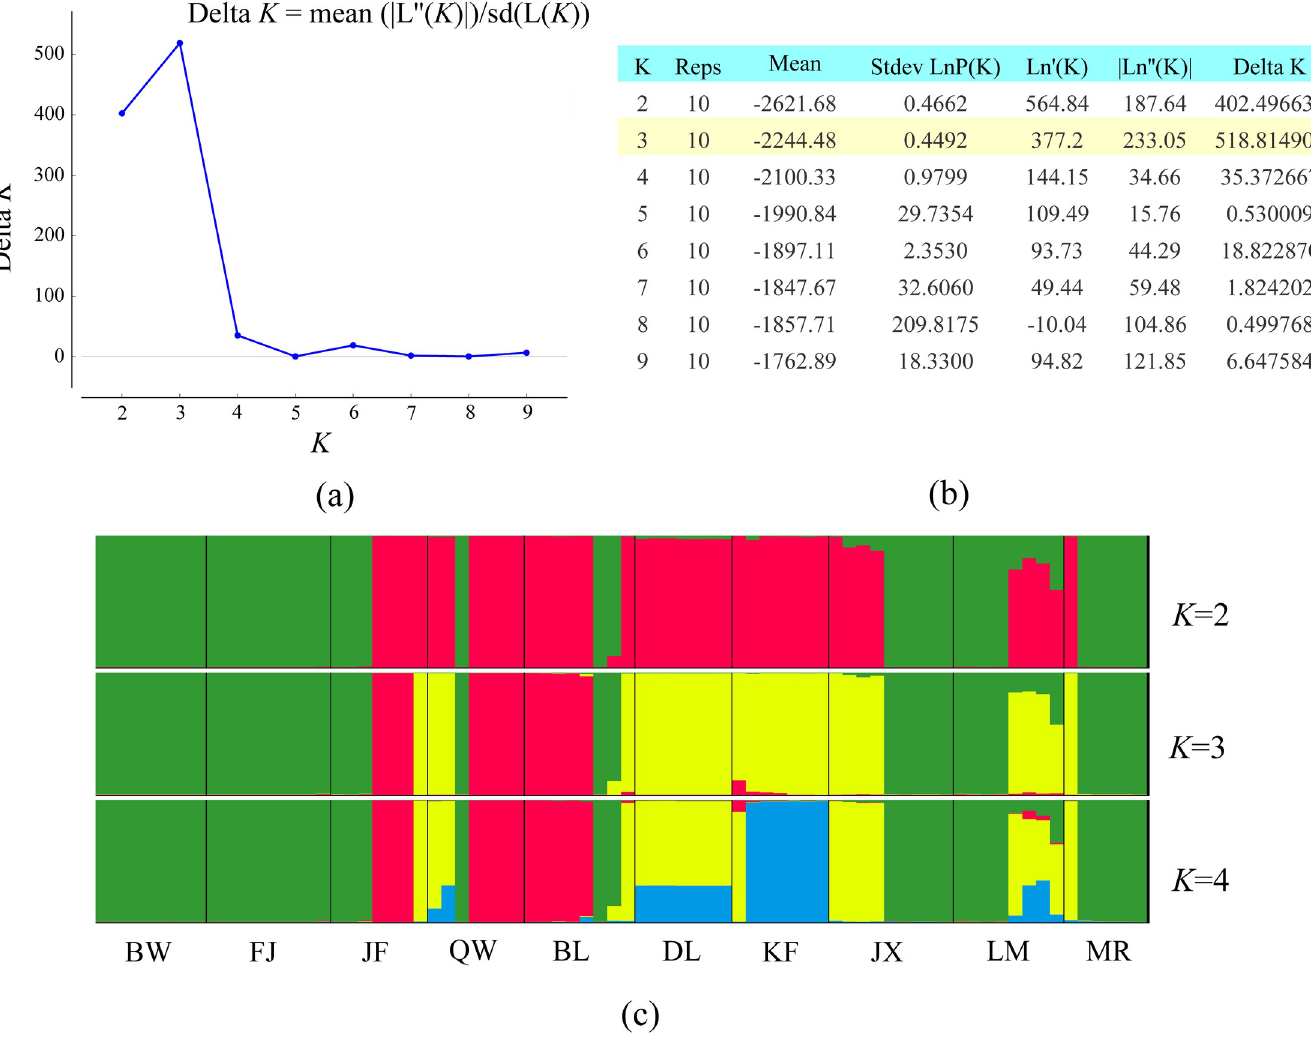
Fig 2. Results of the STRUCTURE analysis. (a) Using the Δ K method, which is based on the rate of change in the log probability of the data between successive K values, the most likely number of clusters was K = 3. (b) Log probabilities and Δ K values for K from two to nine. (c) The results of individual assignment at K = 2, 3 and 4. Each vertical bar represents an individual, and the proportion of the colors corresponds to the posterior probability of assignment to one of the three genetic